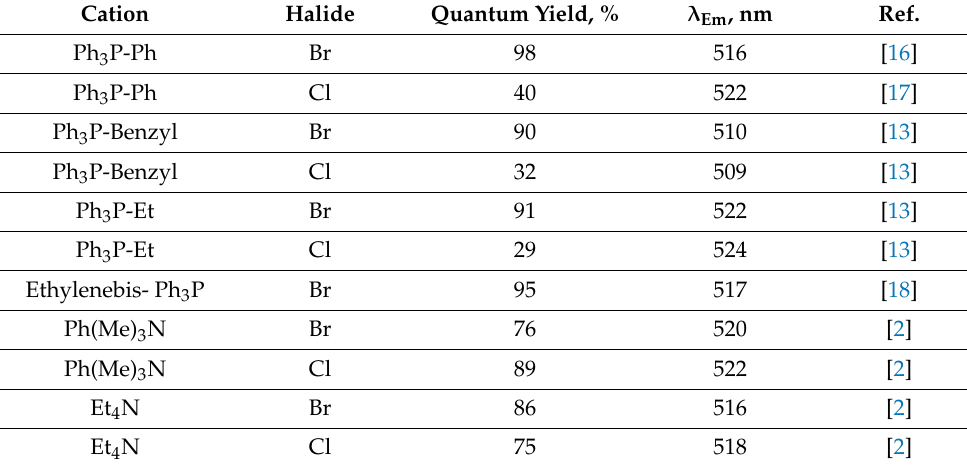
Table 1. Photophysical data (peak position and luminescence quantum yield) for [MnX 4 ] 2 − - containing